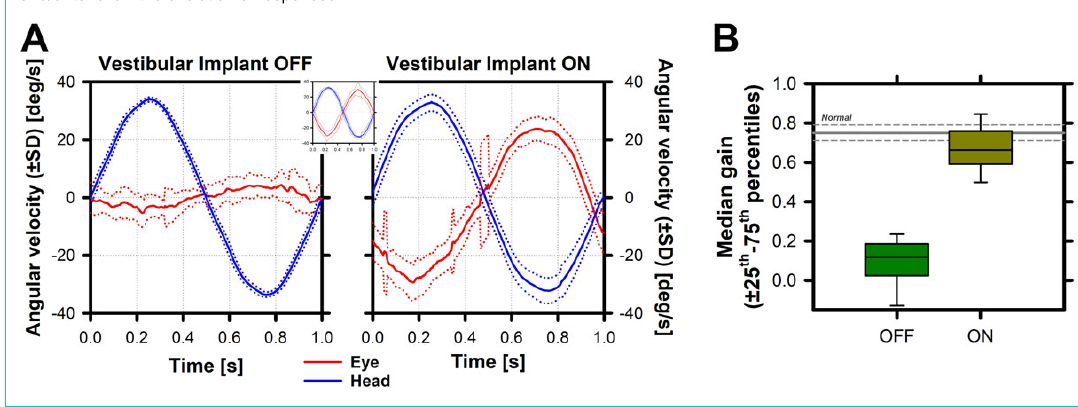
Figure 5: Vestibulo-ocular response measured in a vestibular implant recipient. A Left panel: When the vestibular implant is turned OFF, the vestibulo-ocular reflex (red plot) recorded upon a sinusoidal head movement (blue plot) is practically absent. When the vestibular implant is turned ON, a clear vestibulo-ocular reflex can be recorded, appearing to “mirror” the head movement, similar to what is observed in the healthy vestibulo-ocular reflex (inset between both panels) (57, 80-82). B The gain of the vestibulo-ocular reflex (peak head velocity / peak eye velocity) can then be computed for each experimental condition allowing, for example, the comparison of the efficacy of the “artificial” re- sponse with the “normal” vestibulo-ocular reflex (gray lines in figure 4B), the comparison between conditions/parameters (e.g., OFF vs ON), and/or to follow the evolution of